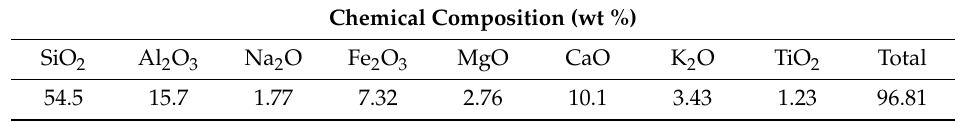
Table 1. Substance types and contents of coal gasification slag